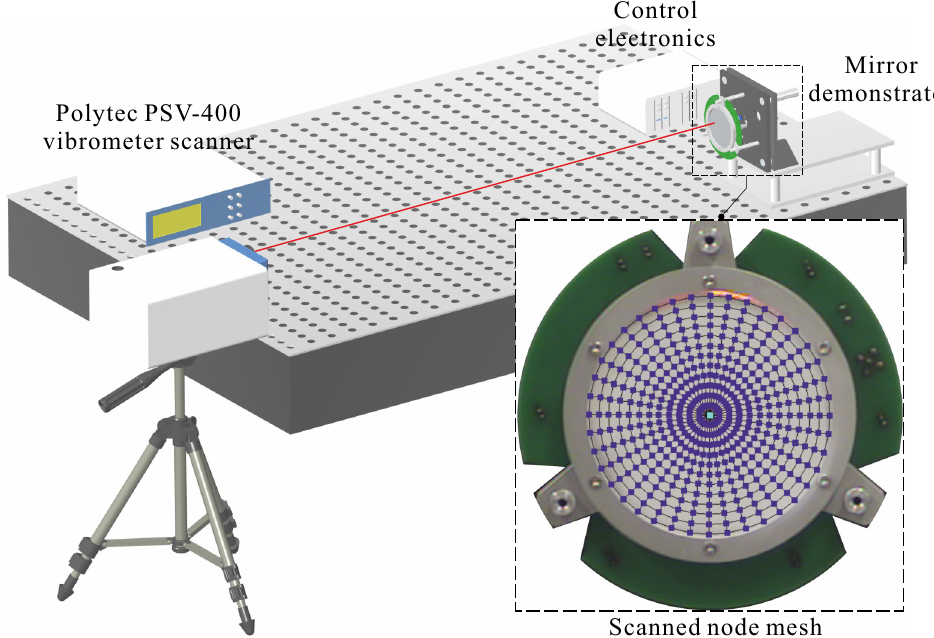
Figure 14. Experimental set up for the laser Doppler velocimeter measurement. The mesh of the scanned nodes is indicated by the blue